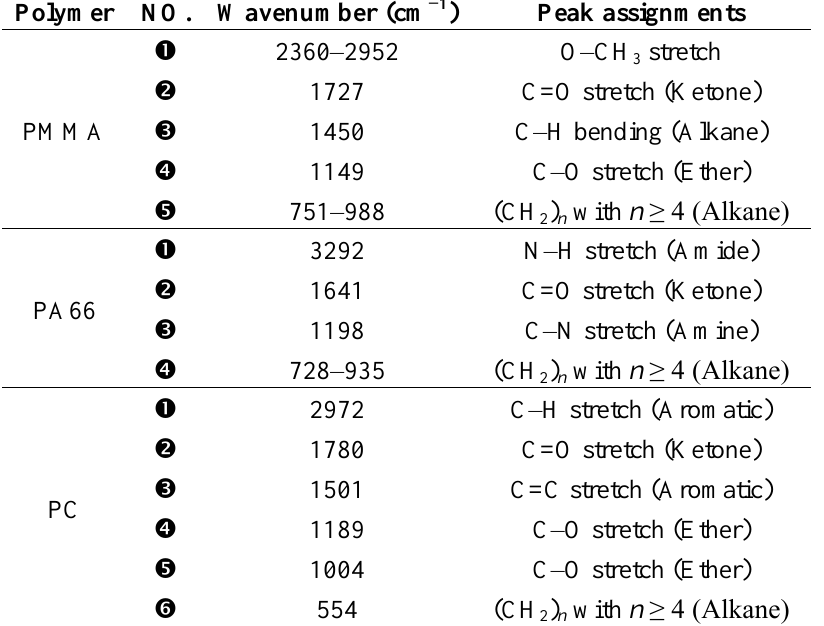
Table 1. The assignment of principal infrared bands of polymethyl methacrylate (PMMA), polyamide (PA66), and polycarbonate (PC).